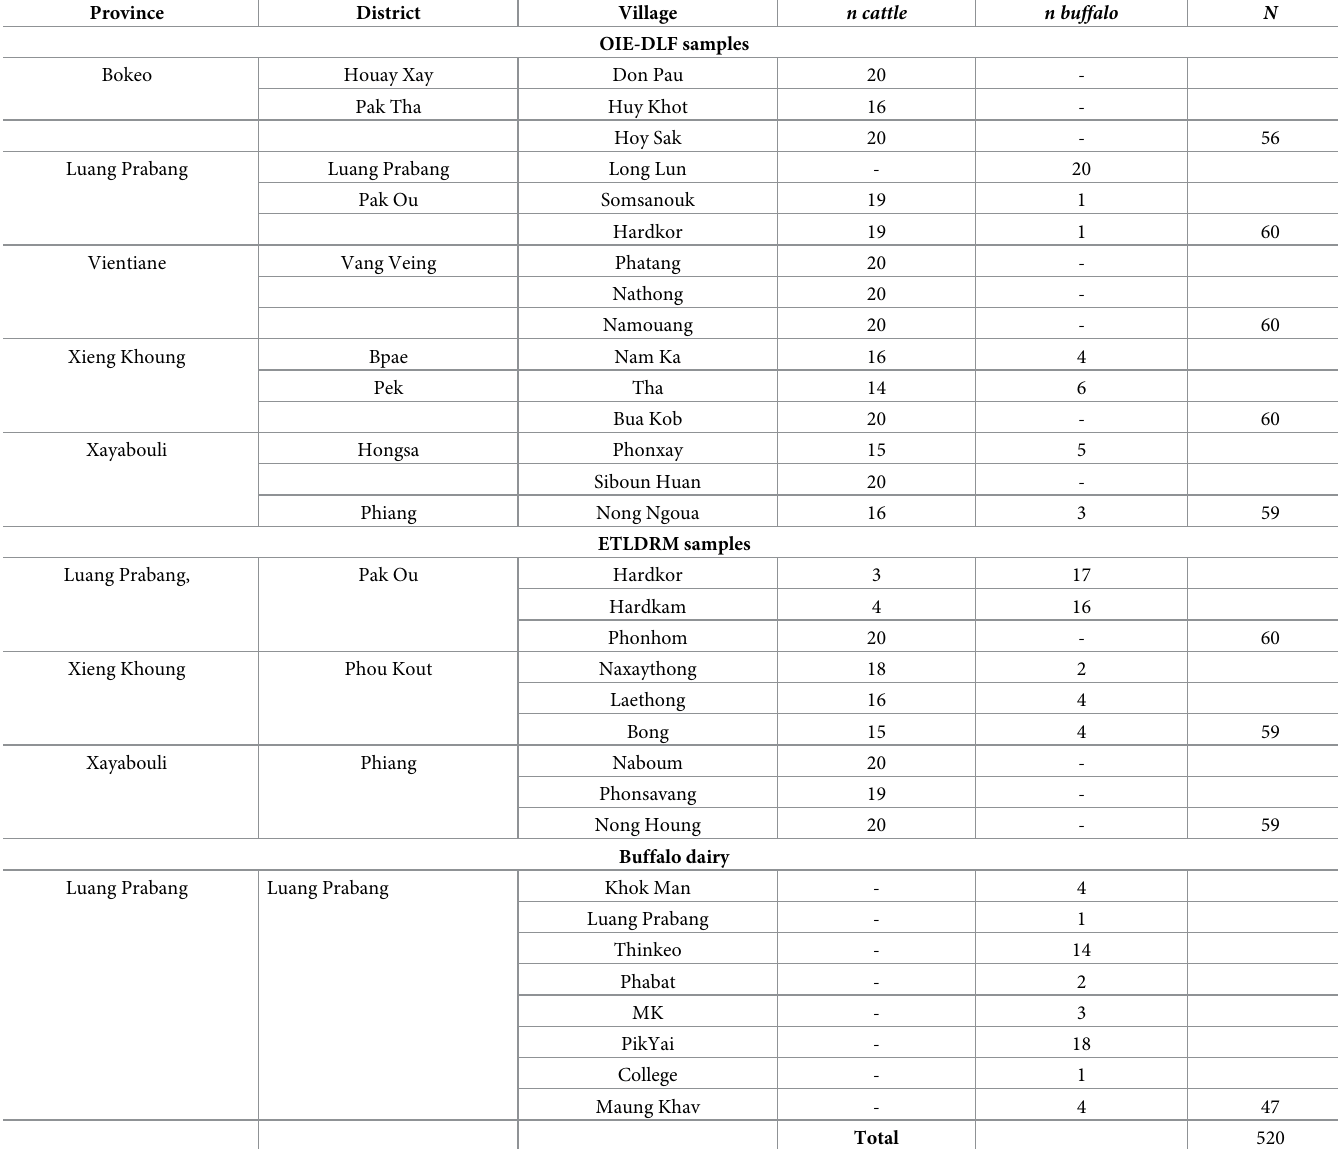
Table 1. Summary of cattle and buffalo serum sample locations from a serological study conducted in Lao PDR in 2018.